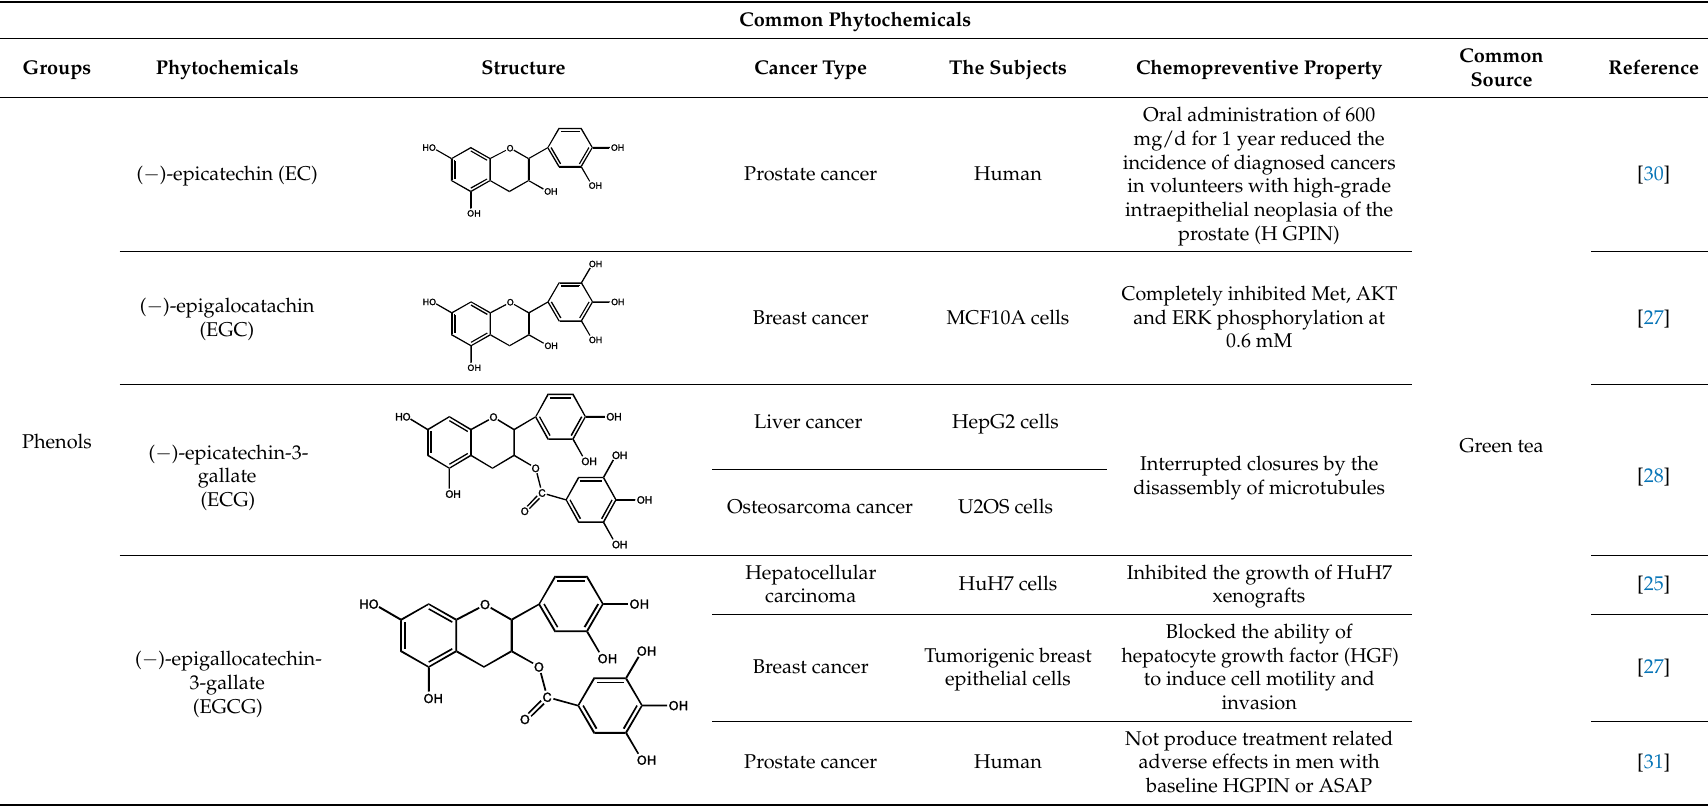
Table 1. Chemopreventive properties of phytochemicals.